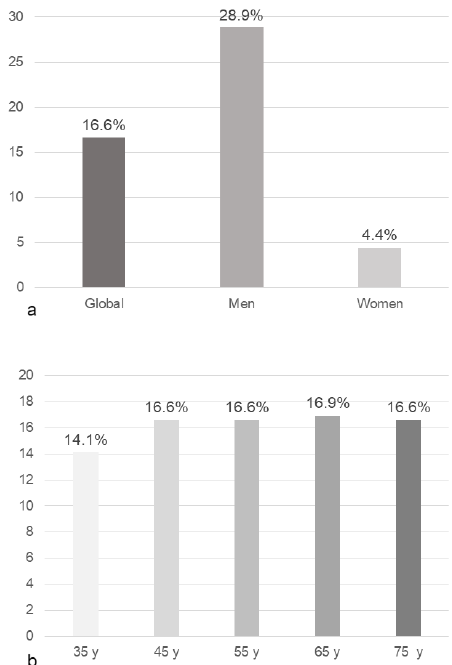
Figure 1. Percentage (%) of subjects with early vascular aging globally, by sex ( a ), and by age group in years ( b ). Y, years. Table 1. General characteristics of the subjects included globally and by vascular